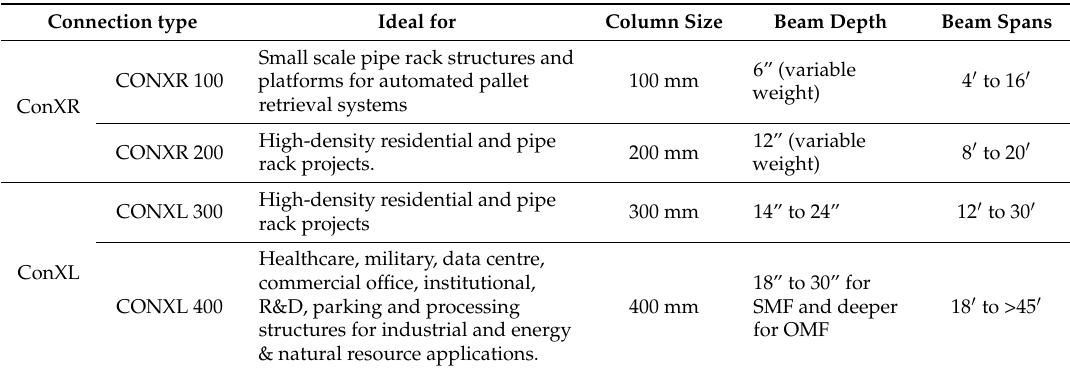
Table 2. Characteristics of the ConXR and ConXL connection types.